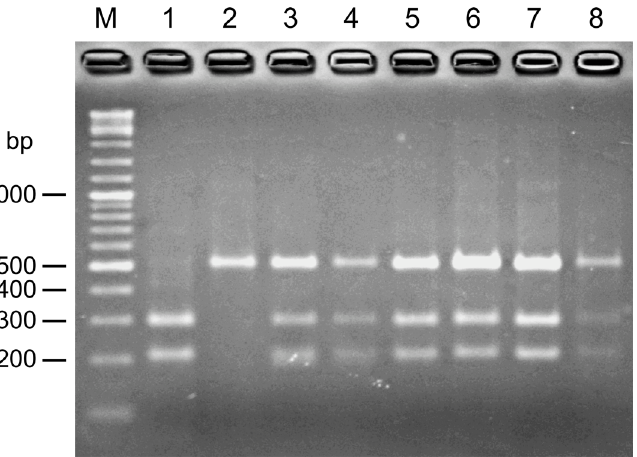
Fig 2. PCR-RFLP analysis of mannose phosphate isomerase (MPI) genes from L . (V . ) peruviana (lane 1), L . (V . ) braziliensis (lane 2), a hybrid of L . (V . ) braziliensis/L . (V . ) peruviana strains LH1099 (lane 3), LC1407 (lane 4), LC1408 (lane 5), LC1418 (lane 6), and LC1419 (lane 7), and Leishmania - positive sand fly 13Hua3-1E (lane 8). PCR amplification was performed with MPI gene-specific primers and the PCR products were digested with Ava II. Lane M, DNA molecular weight